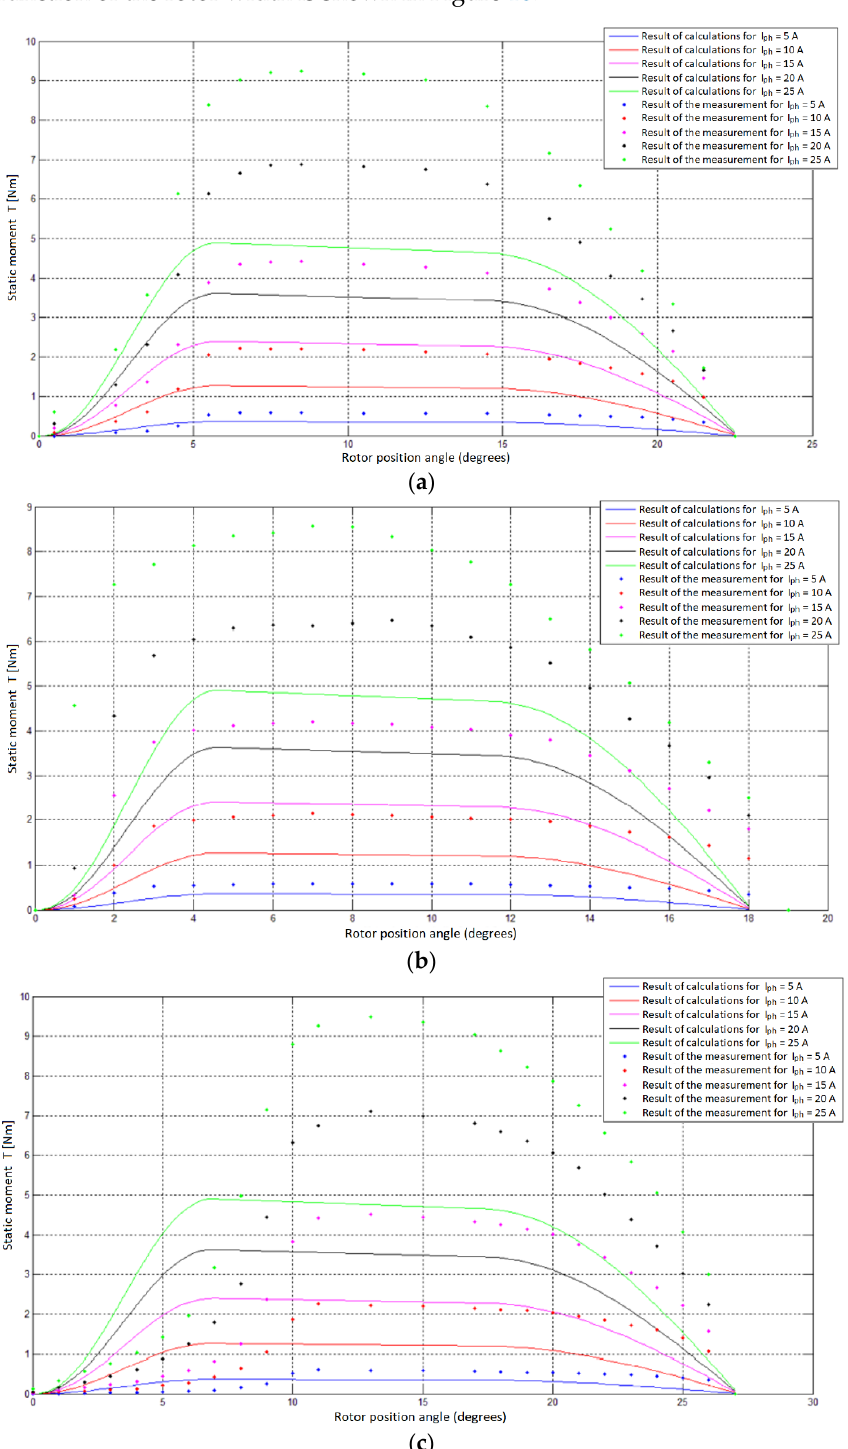
Figure 13. Summary of calculation results (solid lines) with measurement results (dotted lines) for the straight poles SRM 10/8: ( a ) symmetrical; ( b ) asymmetrical (36° angle between poles axis); ( c ) asymmetrical (54° angle between poles axis).